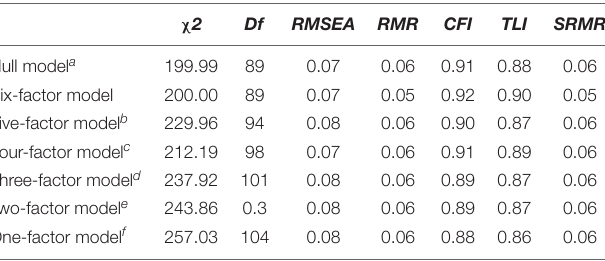
TABLE 2 | Results of confirmatory factor analysis for the measures of the variables